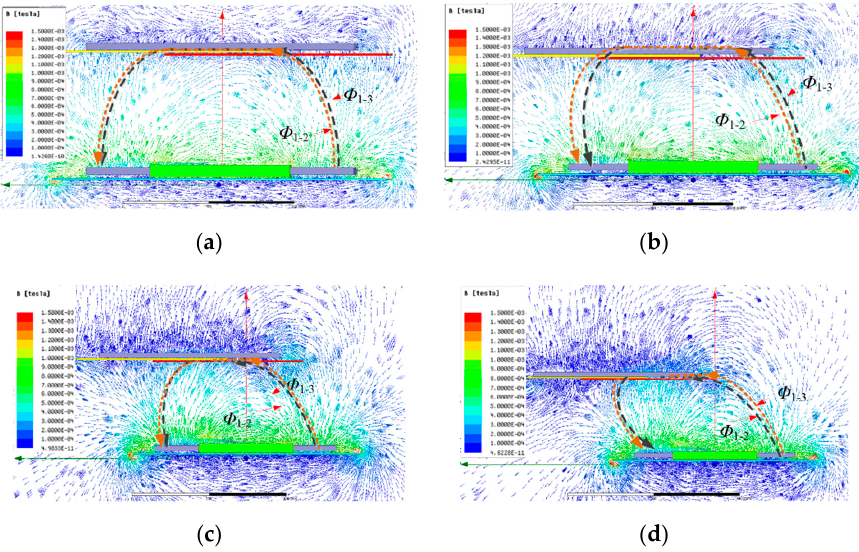
Figure 10. FEM simulation misalignment positions alongside ferrite direction: ( a ) aligned position; ( b ) 80 mm; ( c ) 150 mm; ( d ) 300 mm.